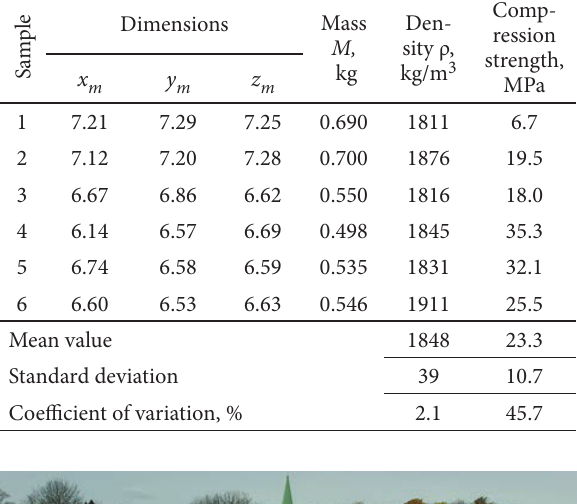
Table 6. Results of compression strength test of the